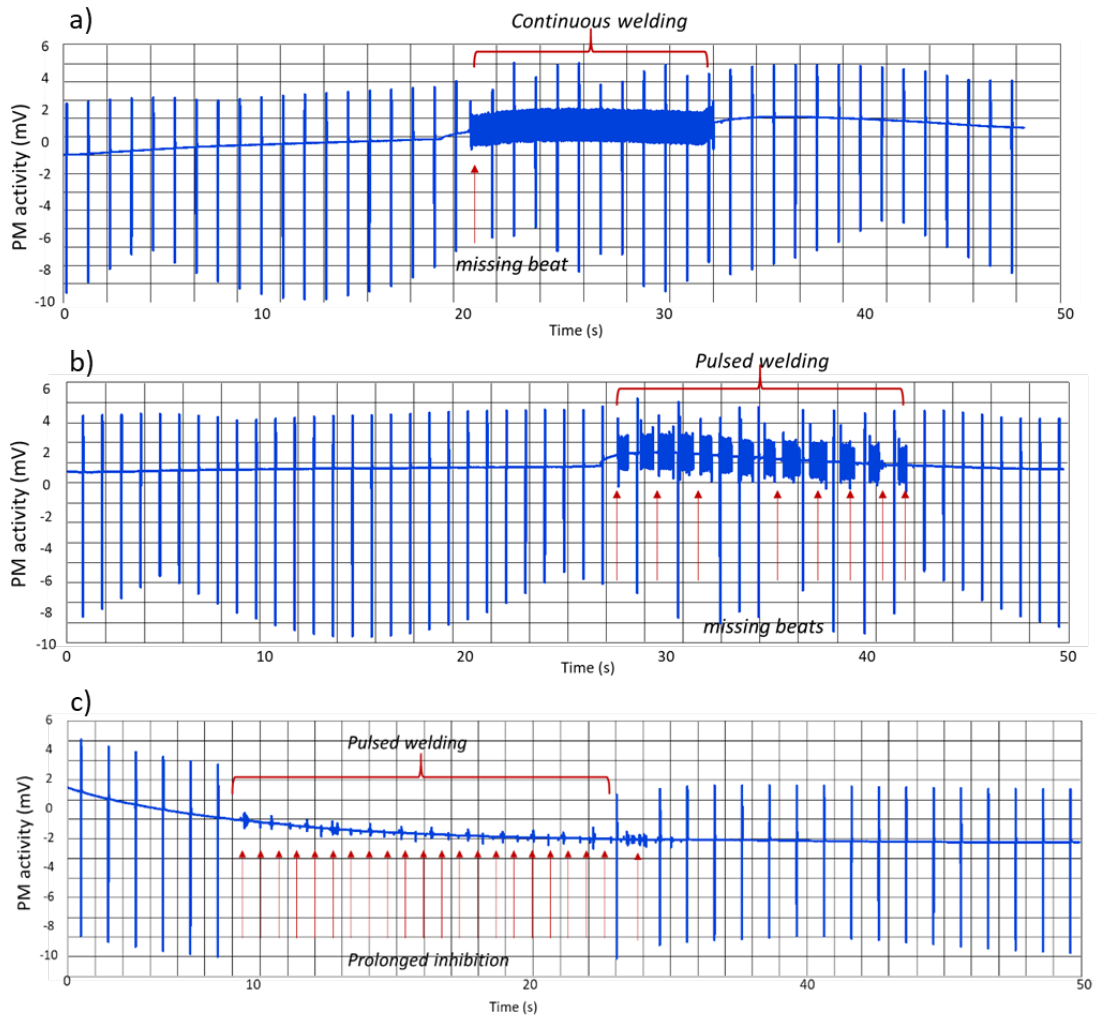
Figure 7. Example of PM activity recorded during the activation of the arc welder. The cable of the welding system was placed over the shoulder of the phantom (one or both). ( a ) Single beat missed at the beginning of the continuous welding; ( b , c ) prolonged inhibition during pulsed welding.